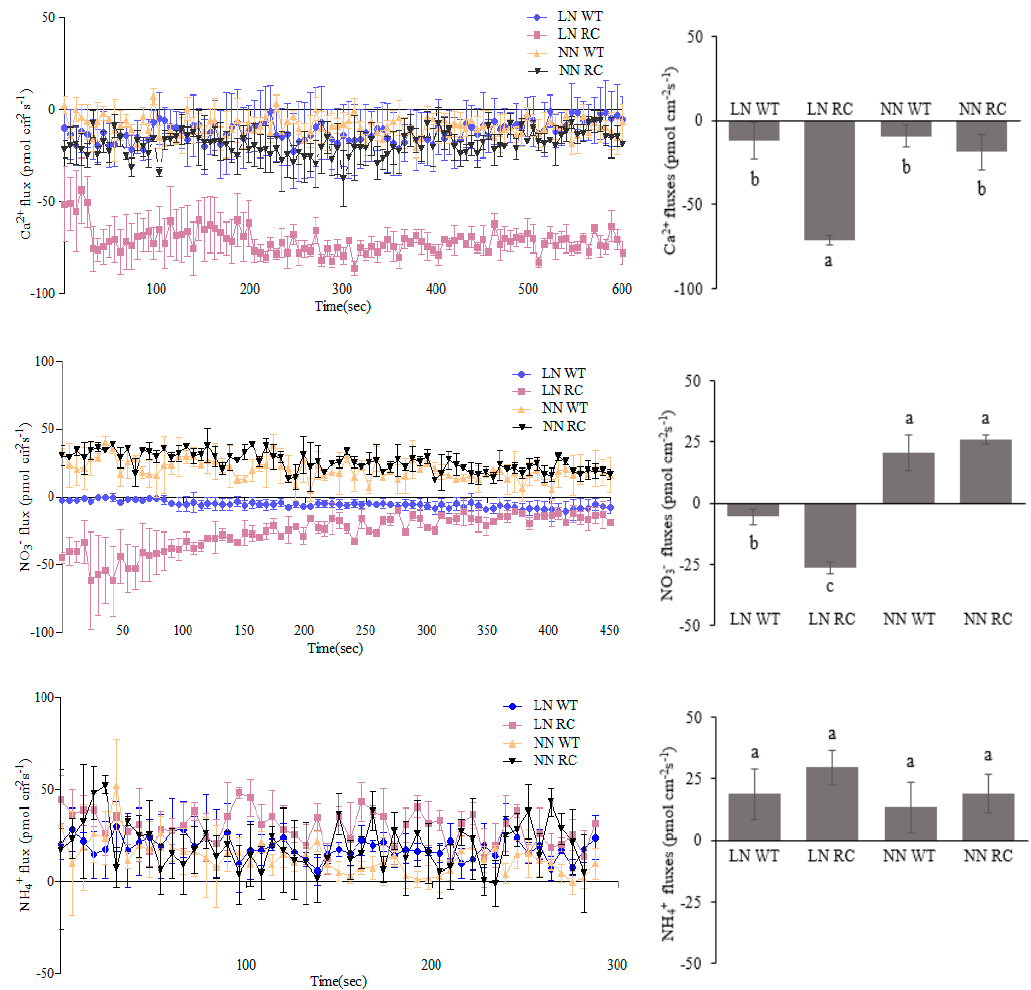
Figure 7. The Ca 2+ ,NO 3 − , and NH 4+ fluxes of rice root under different N treatments. Left panel represents the flux rate in real time (vertical bars shows the standard erors). Right panel graph represents the total (average) influx and efflux rate. Different small letters beyond the column mean significant difference ( p < 0.05) calculated by LSD’s test.